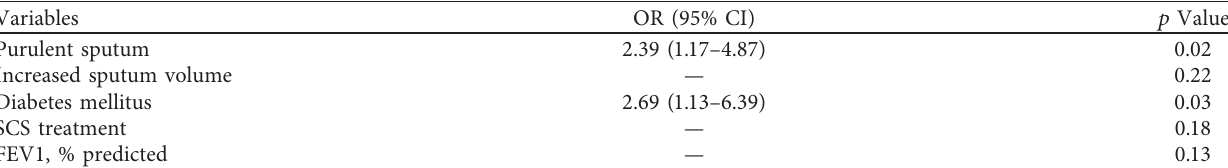
Figure 2: Receiver operating characteristic (ROC) curves of CRP, PCT, Neu, and OPN for differentiating between pneumonic and nonpneumonic exacerbations in AECOPD patients. Table 4: A logistic regression model for predicting CAP in AECOPD by clinical symptoms.